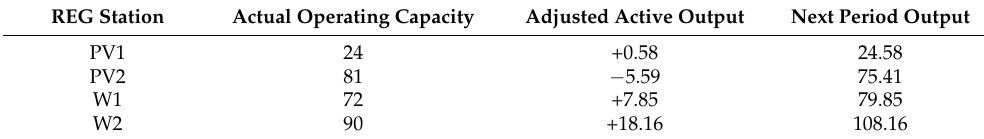
Table 3. The output of each REG station in the current and next period/MW.